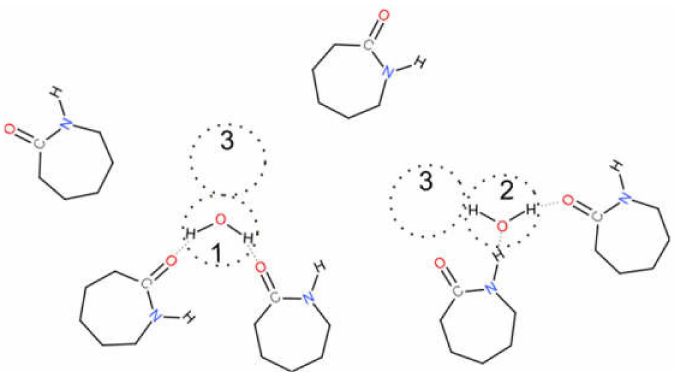
Figure 5. Model for adsorption of water in ε -caprolactam at saturated vapor pressure; 1, solid bound water; 2, loose bound water; 3, sites for capillary condensation